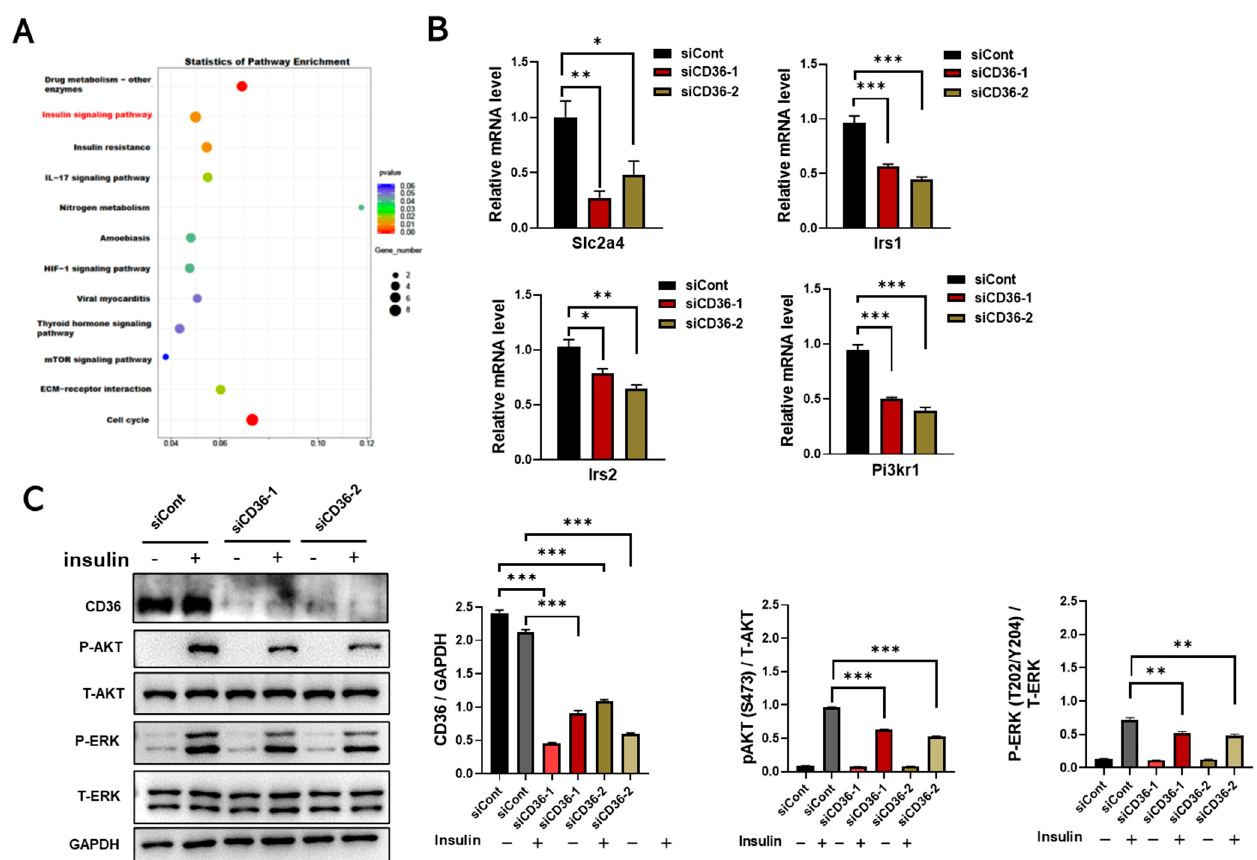
Figure 2. Loss of CD36 impairs insulin signaling in C2C12 myotubes without PA loading. ( A ) KEGG pathway analysis of differentiated C2C12 cells after transfection with scrambled siCont or siCD36. ( B ) Gene expression of Slc2a4, Irs1, Irs2, and Pi3kr1 in an insulin-signaling pathway was analyzed by qRT-PCR in differentiated C2C12 myotubes after transfection with siCont or siCD36. ( C ) Western blot analysis and quantification of insulin- induced CD36, P-AKT (S473), total AKT (T-AKT), P-ERK (T202/Y204), and total ERK (T-ERK) expression levels in differentiated C2C12 cells after transfection with siCont or siCD36. Values are presented as the mean ± SEM of three independent experiments. * p < 0.05, ** p < 0.01, *** p < 0.001 versus the siCont group.